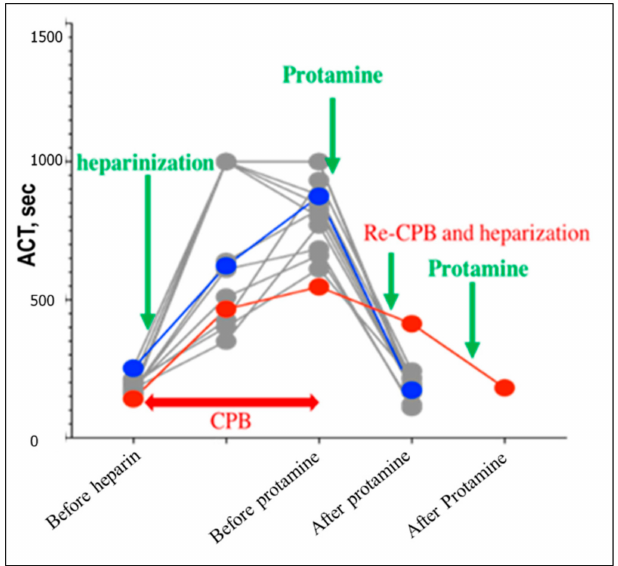
Figure 3. Plotting of the activated clotting time (ACT) throughout the cardiopulmonary bypass of dogs undergoing mitral valvoplasty. Gray dots resemble dogs from the non-hypotensive group. Hypotensive dog number one and dog number two were dotted red and blue, respectively. The examination time was set before heparinization, before the first protamine, and before the second protamine administration in all dogs. In hypotensive dog number two, the ACT was evaluated also after